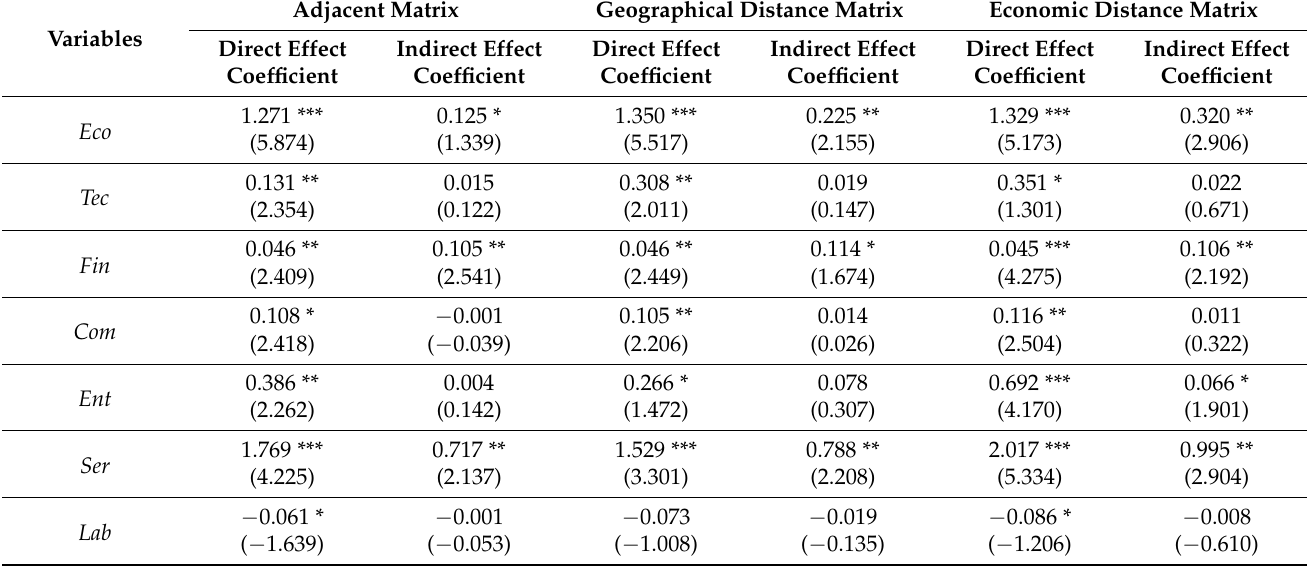
Table 5. Direct and indirect effects of explanatory variables based on three spatial weight matrices. Adjacent Variables